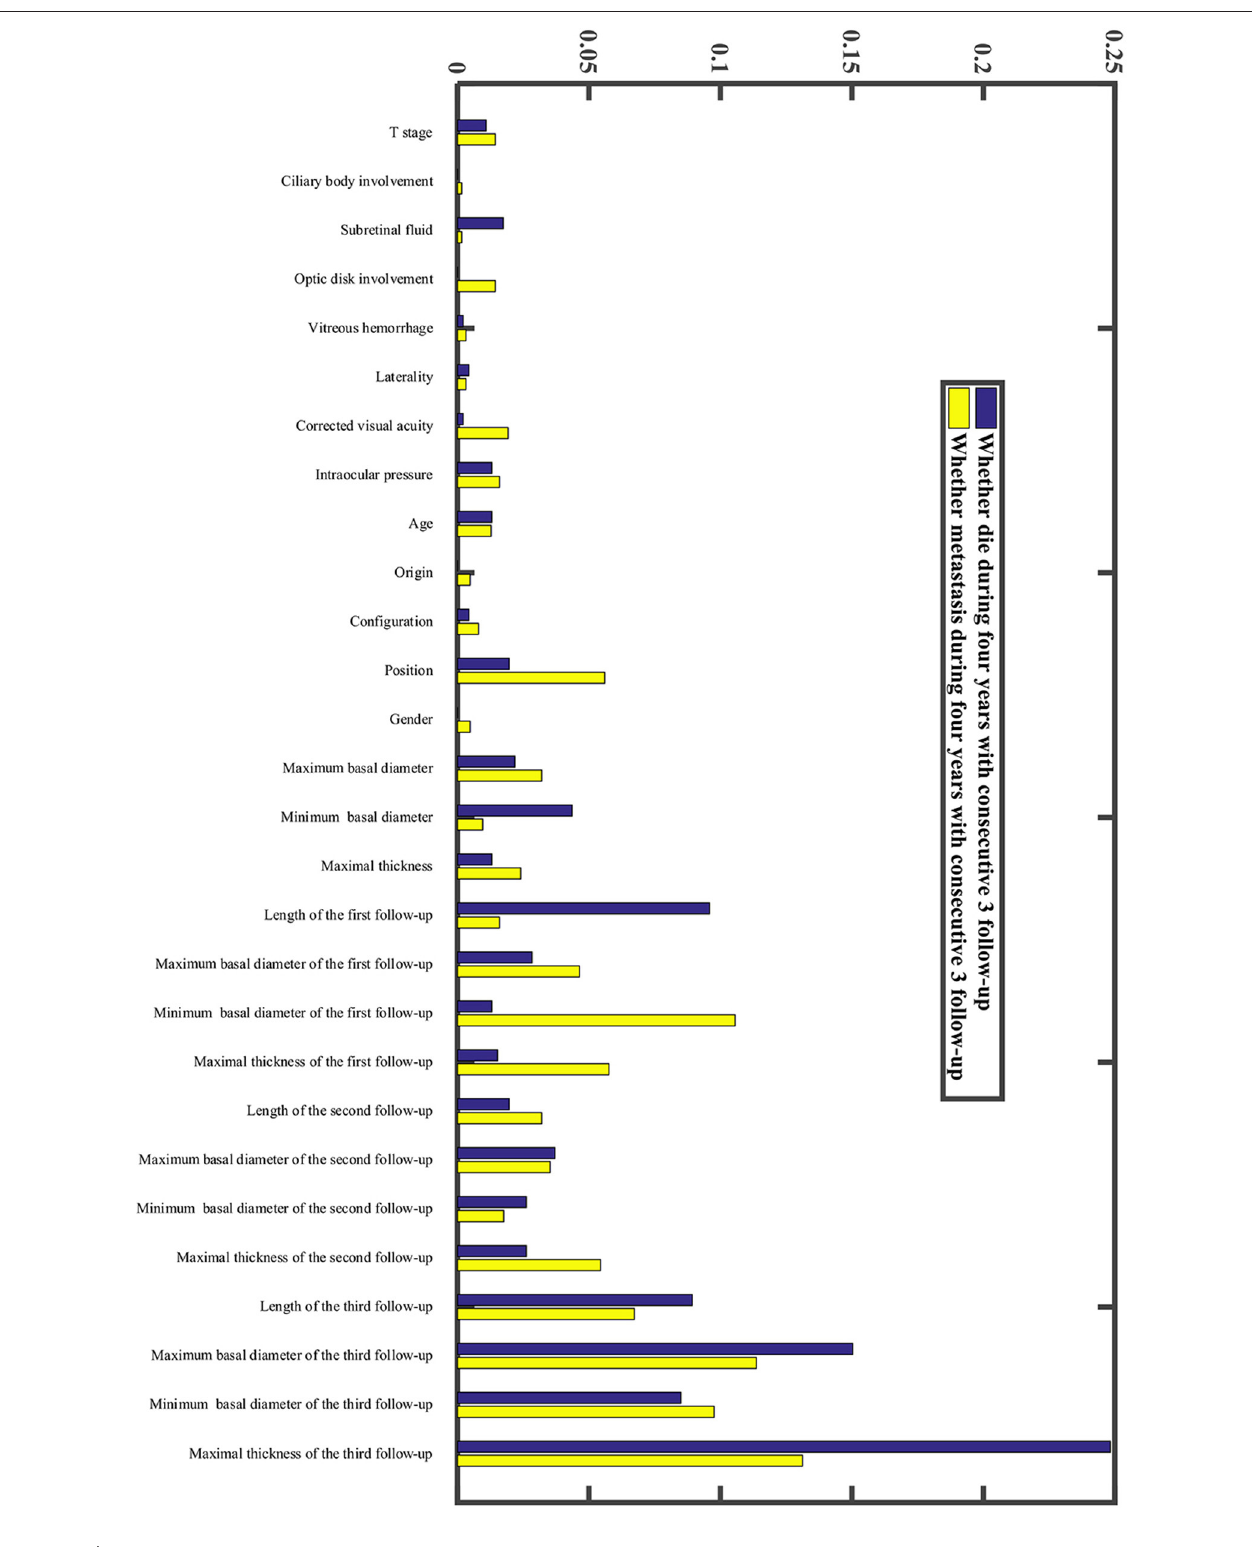
FIGURE 5 | Relative importance of each factor in the machine learning model.